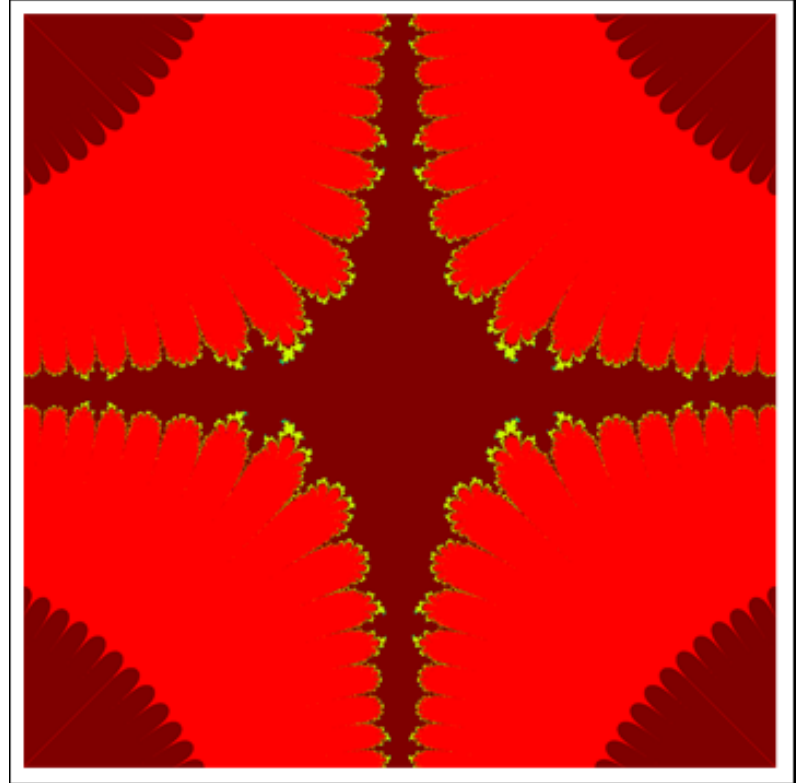
Figure 7. J-set for τ ( z ) = sin ( z 2 ) + c via DKIS. The image execution time is 564.06